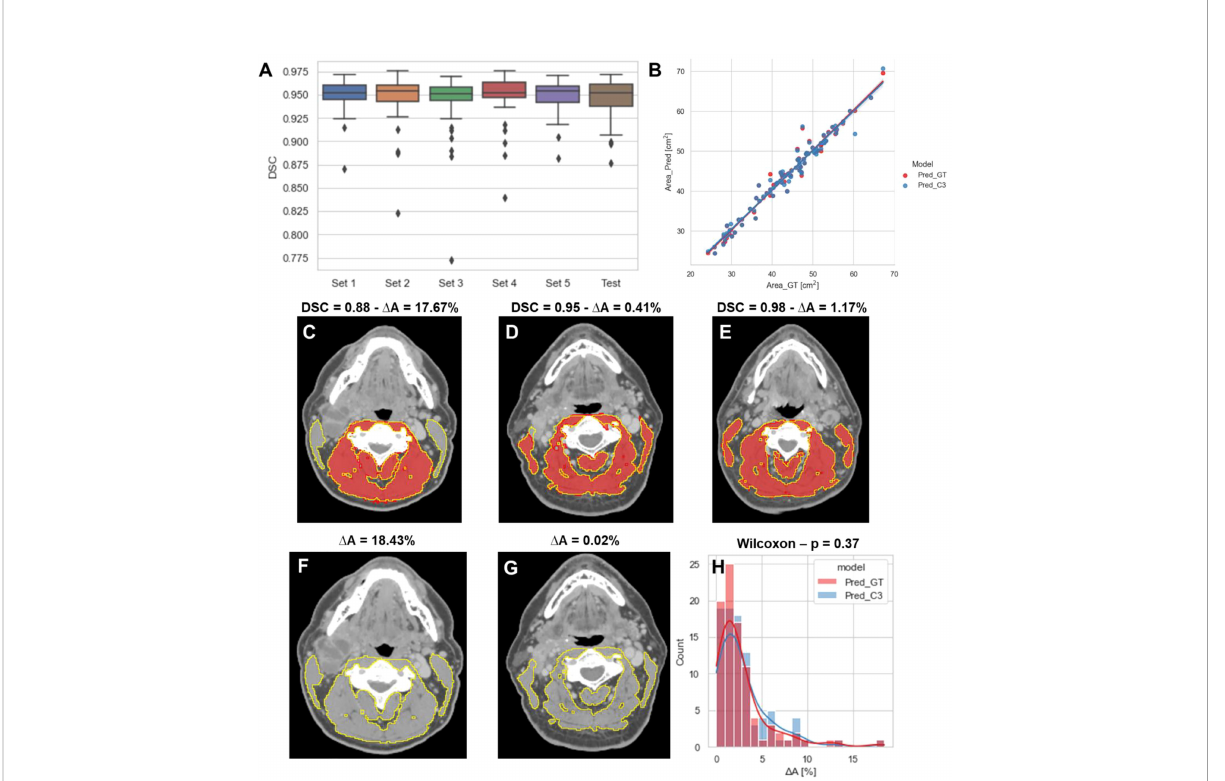
FIGURE 3 2D ResUNet model performance for segmentation of C3 skeletal muscle (SM). (A) Boxplots of the Dice similarity coef fi cient (DSC) distributions for the 5-fold cross-validation datasets (Set 1 to Set 5 – 60 patients each) and the test data (90 patients). (B) A scatter plot of the SM cross-sectional area using the ground-truth manual segmentation (x-axis) and the SM cross-sectional areas (y-axis) using predicted segmentations of the 2D ResUNet applied to the ground-truth CT image slice (Pred_GT) and the auto-selected CT image slice using the C3 section auto-segmentation (Pred_C3). Illustrative examples overlaying the skeletal muscle (SM) ground-truth segmentations (red) and predicted segmentations (yellow) on the same ground-truth CT images (C-E) and auto-selected CT images (F, G) with different DSC values (low – 0.88, medium - 0.95, and high – 0.98 compared to the mean estimated DSC value of 0.95). The auto-selected CT image for the high-performance example was identical to the ground- truth image and therefore provided the same segmentation as shown in panel C (H) Histogram of percentage difference of SM cross-sectional areas between ground-truth segmentations compared to the predicted SM cross-sectional areas ( D A%) corresponding to the model using ground- truth slice location (red) or auto-selected slice location